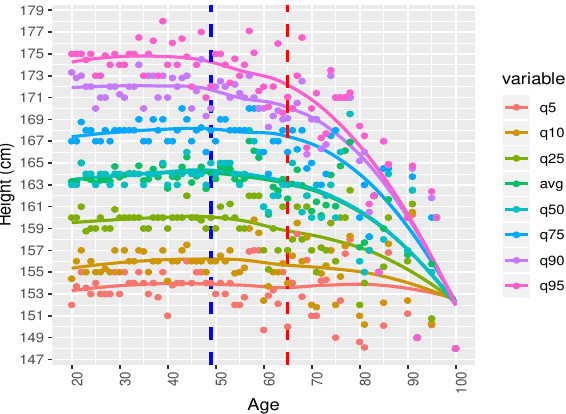
Figure 8. Distribution of Male Height (Age: 20–100) after applying loess method ( N = 13,932).